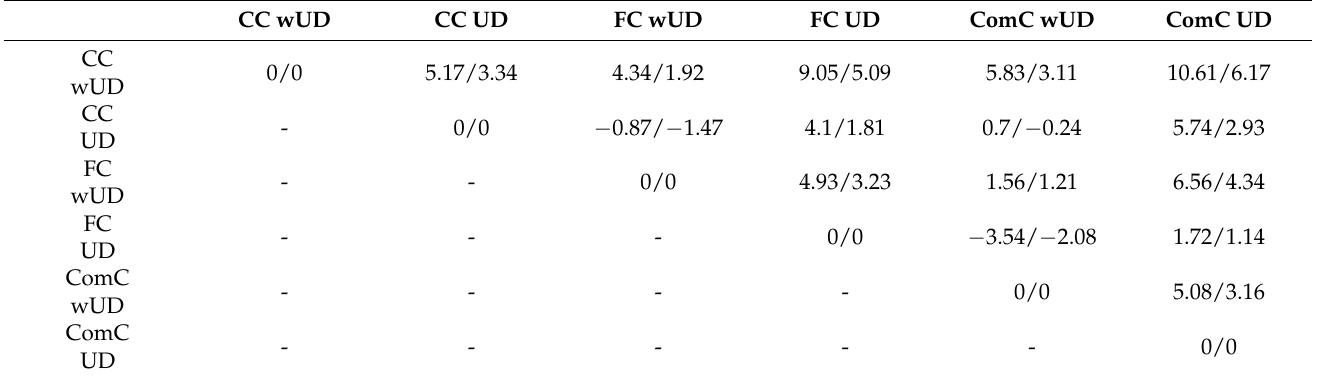
Table 7. Comparison of energy efficiency of well control methods.